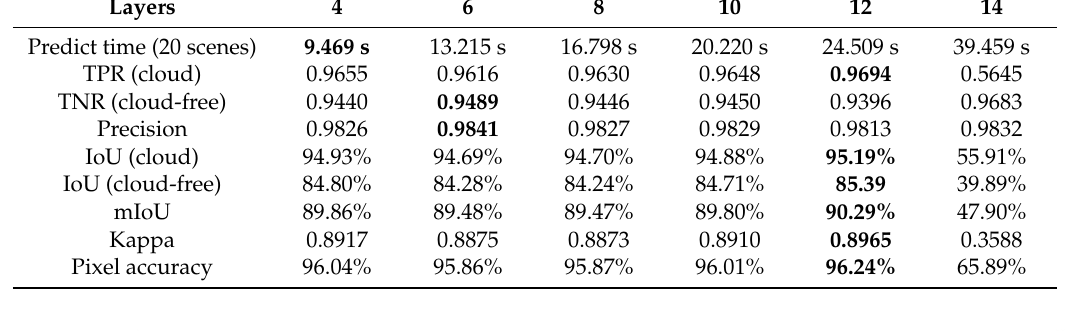
Figure 9. Visual evaluation of various DL architectures in classifying clouds, using eight regions with different types and forms of cloud presented as eight RGB images and predicted cloud masks.